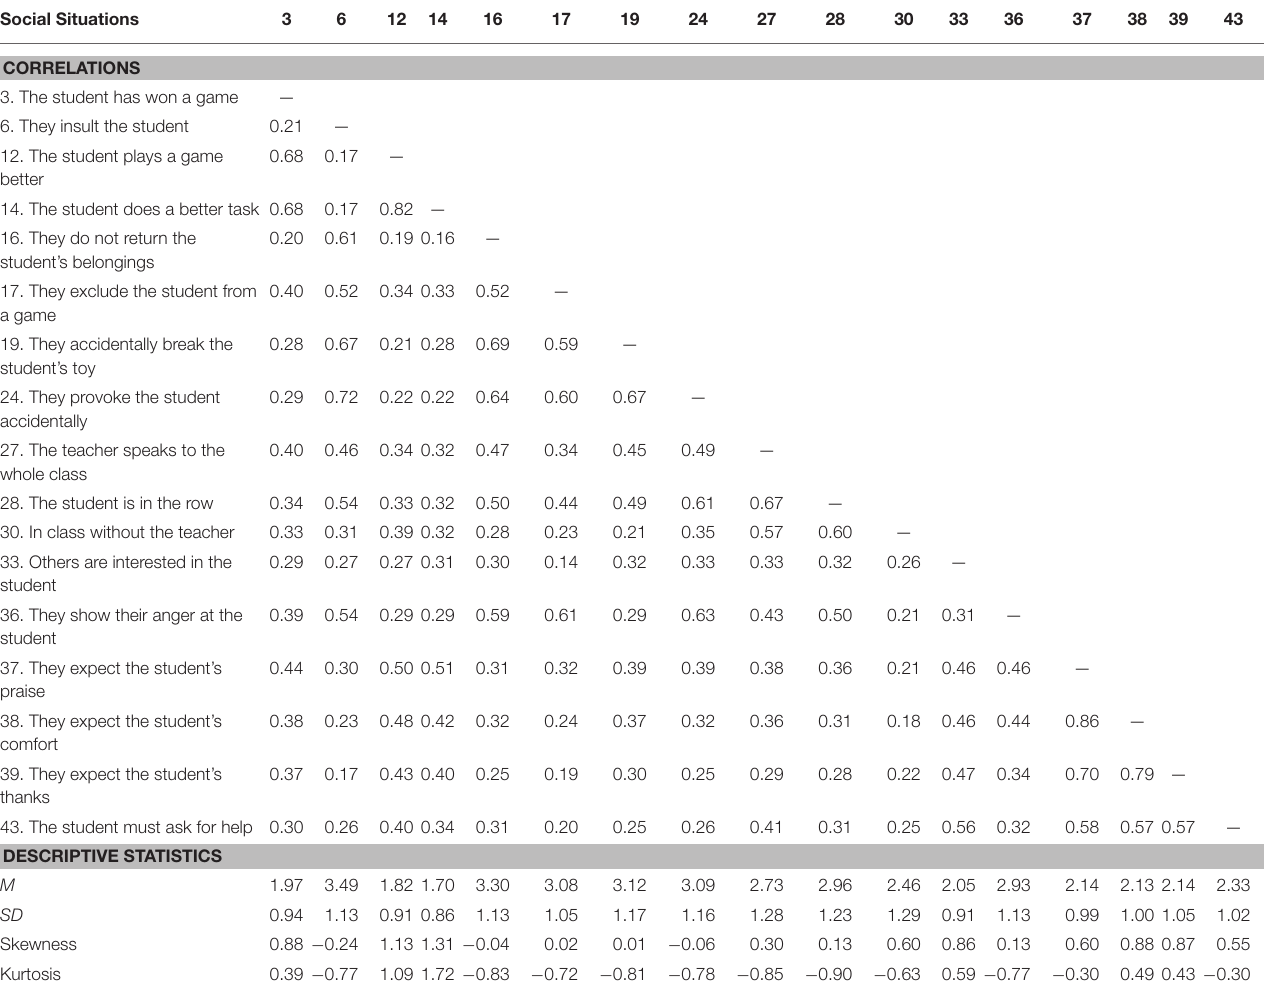
TABLE 1 | Polychoric Correlation Matrix and Descriptive Statistics of the Social Situations ( n = 169). Social